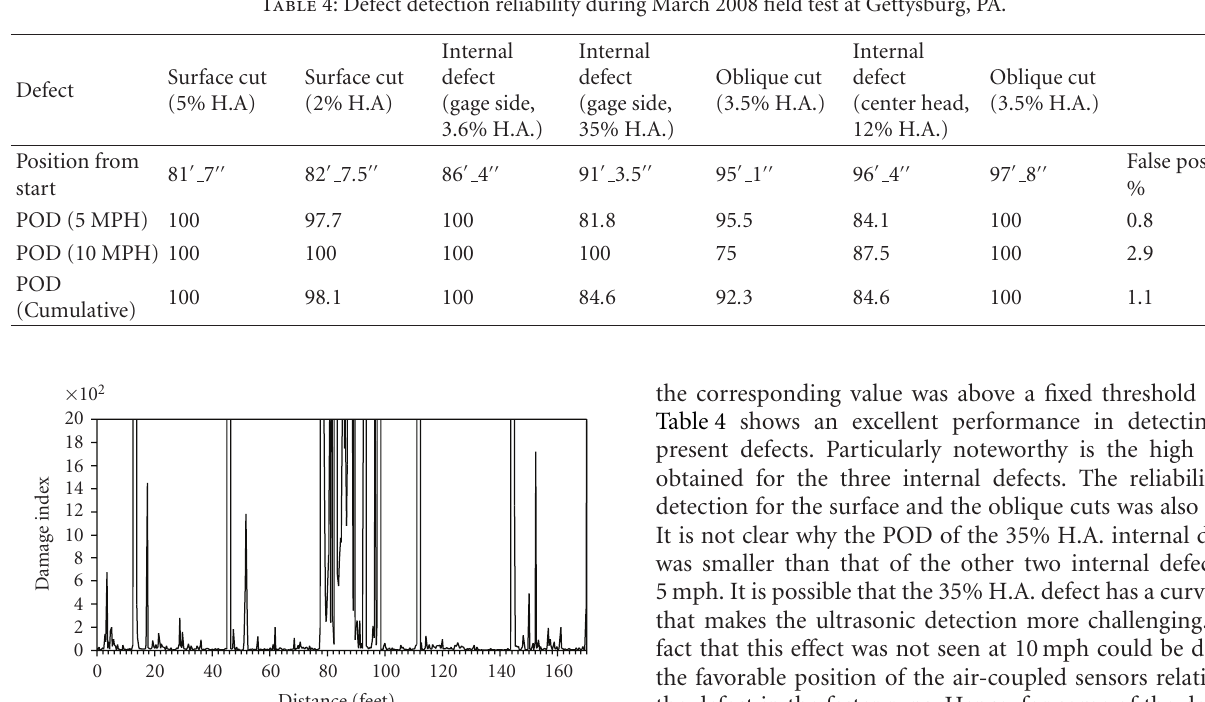
Table 4: Defect detection reliability during March 2008 field test at Gettysburg, PA.